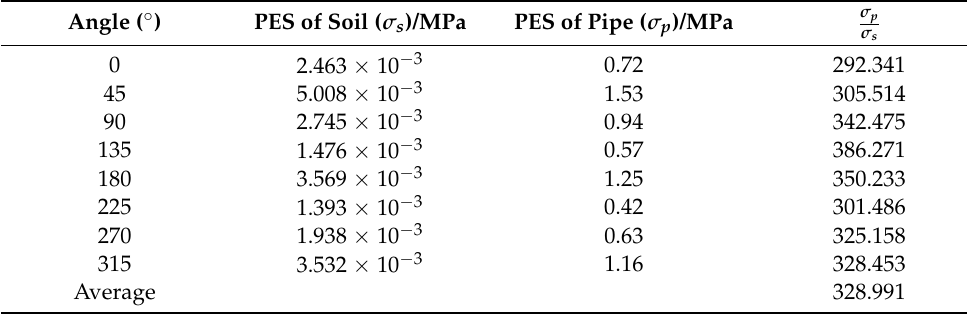
Table 8. PES ratio of buried pipe and its attached